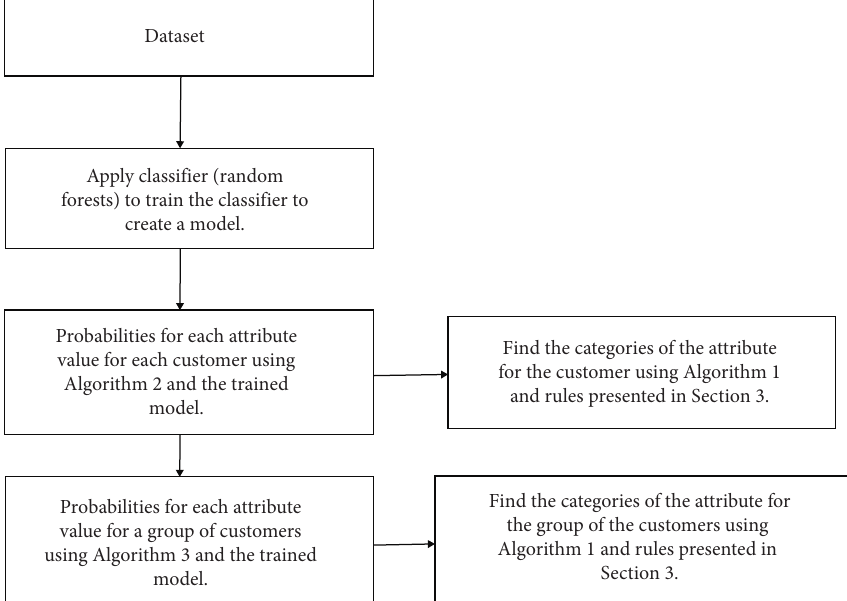
Figure 1: Flowchart of the proposed method to find the Kano categories of attributes for a customer and a group of